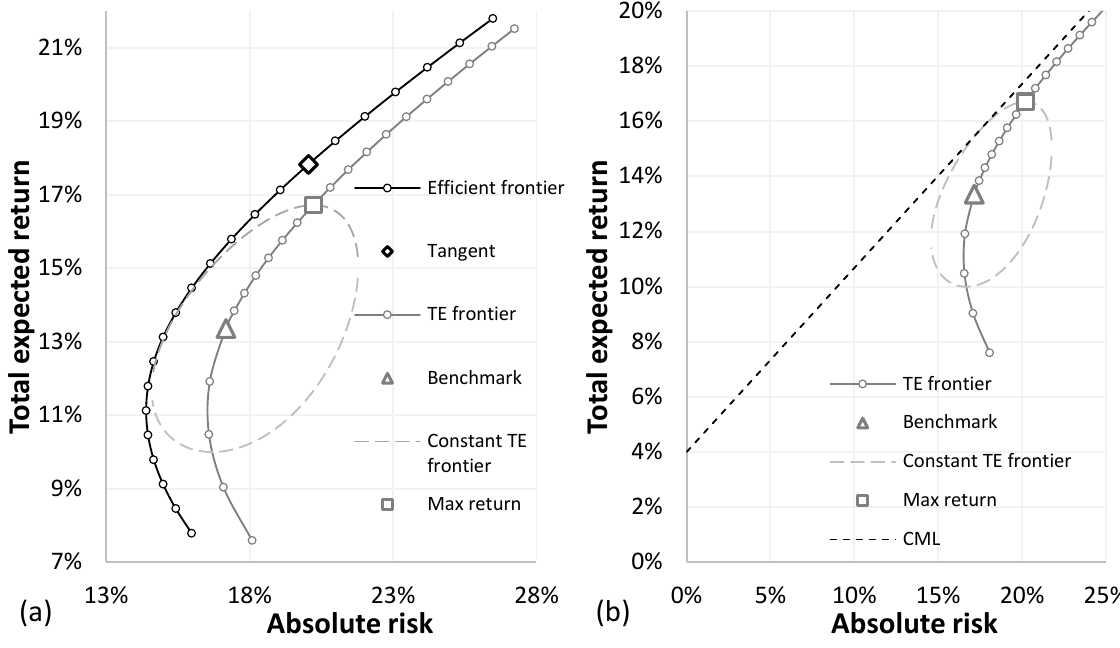
Figure 1. (a) Efficient frontier, TE frontier and constant TE frontier and (b) efficient frontier, TE frontier and constant TE frontier and capital market line (CML) in mean/standard deviation